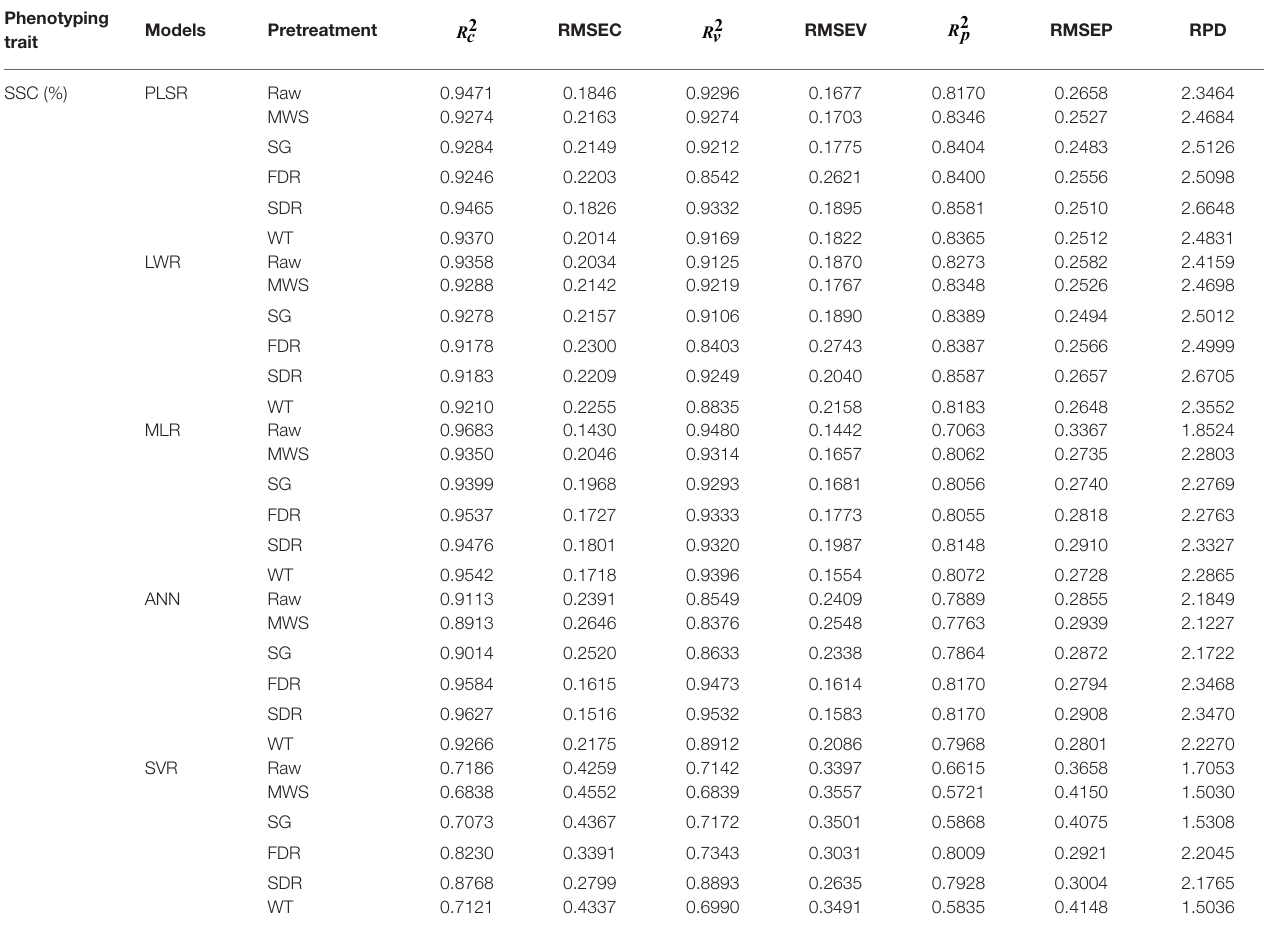
TABLE 3 | Prediction of the SSC of lettuces based on various multivariate analysis methods. Phenotyping trait